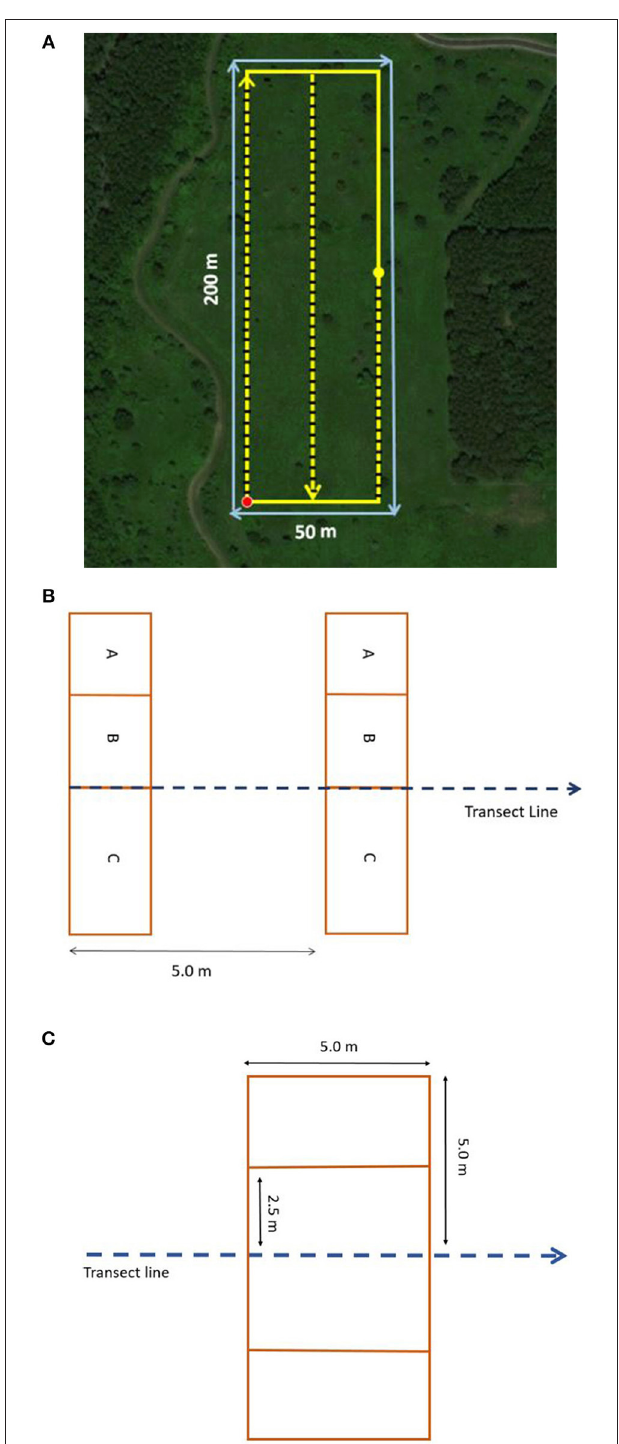
FIGURE 2 | (A) Standard 1-ha sampling plot layout, anchored at random sampling point (red dot), 200m by 50m. Plots are defined with an ArcGIS Online mapping tool to minimize bias derived from habitat conditions encountered in the field. From a random point, we anchor a rectangle within patchofparticularland-usetype(mustinclude < 10%non-targetland-usetype).